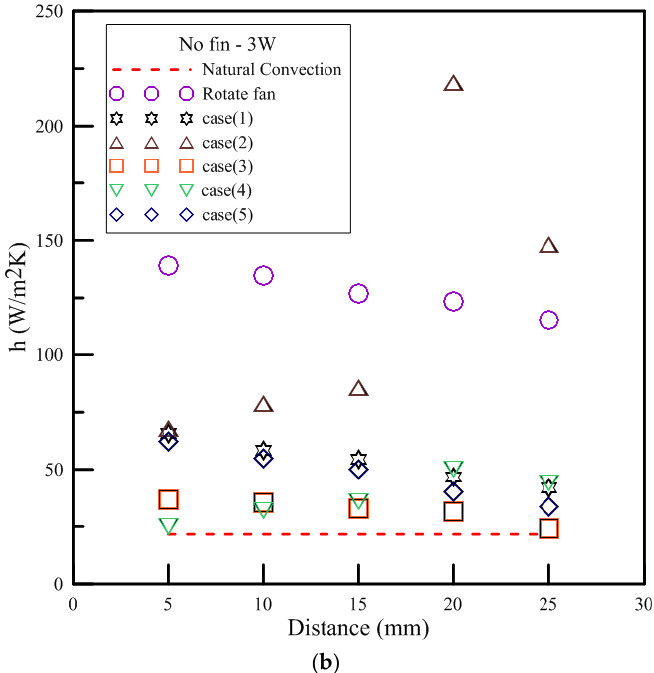
Figure 11. 3W LED experimental data. ( a ) Position vs. total thermal resistance ( b ) Position vs. heat convection coefficient.